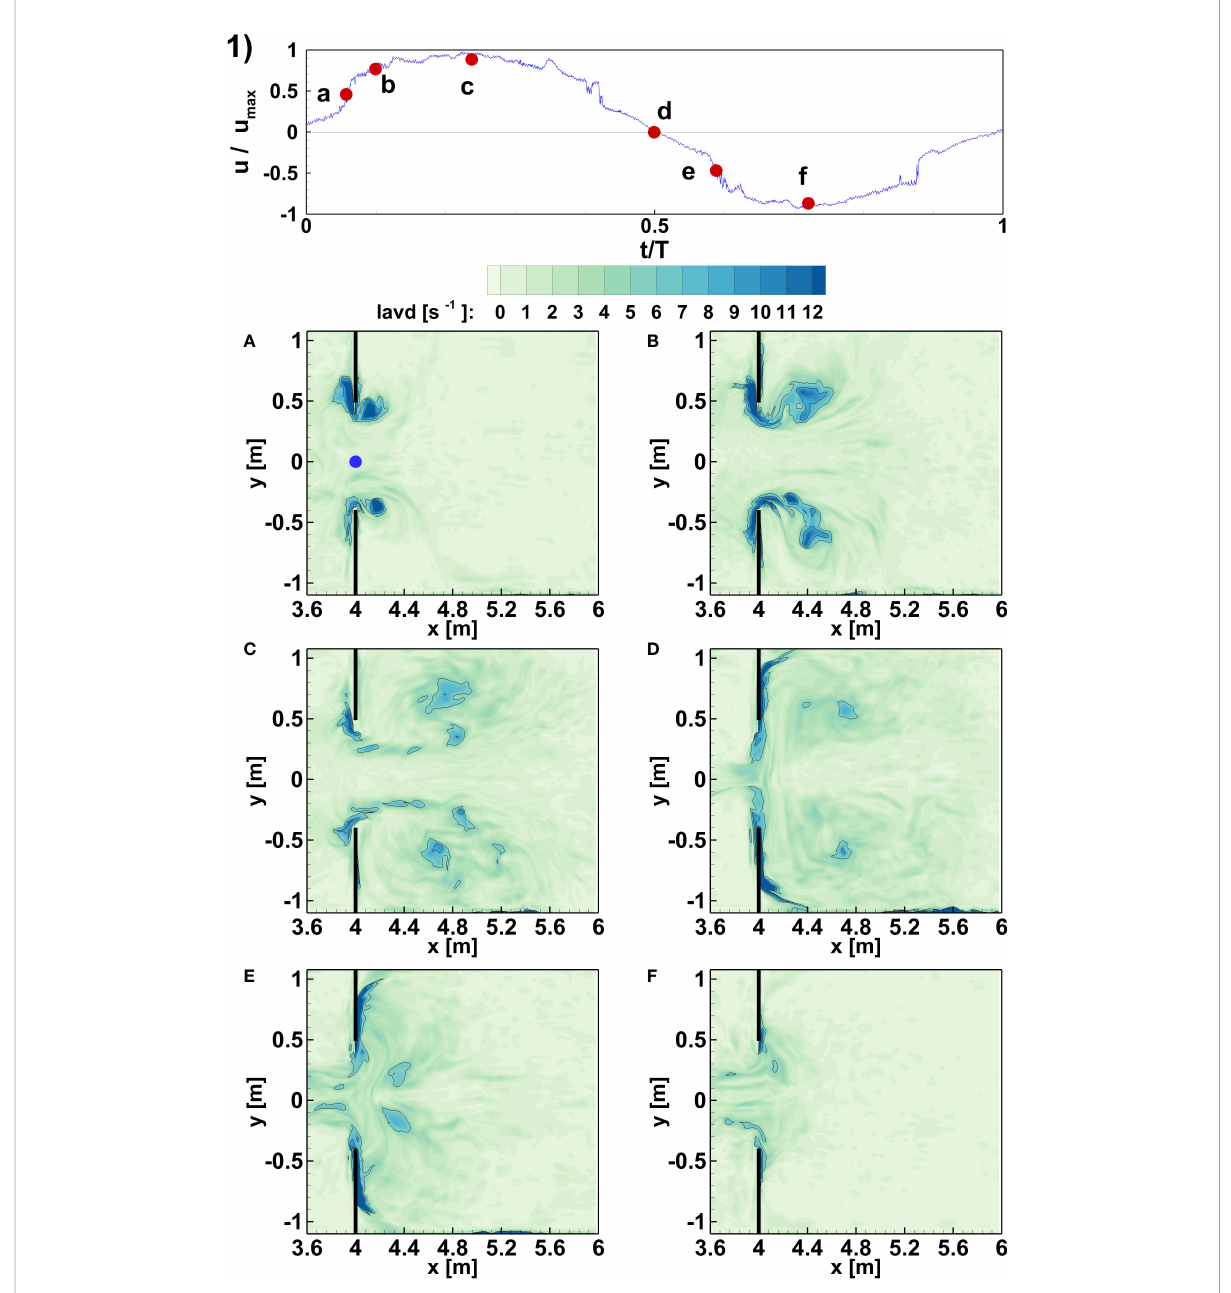
FIGURE 6 Panel 1) Non dimensional horizontal velocity u/umax as a function of the ratio between time and tidal period. The time signal is extracted at a coordinate x = 4 m and y = 0 m, marked by a blue dot in panel (A) . Red dots correspond to panel names below. Panels (A – F) Contours of LAVD at different times. In particular panels (A – D) correspond to fl ood phase and panels (E, F) to ebb phase. Note that domain reported is restricted to the region around the inlet. Data from experiment